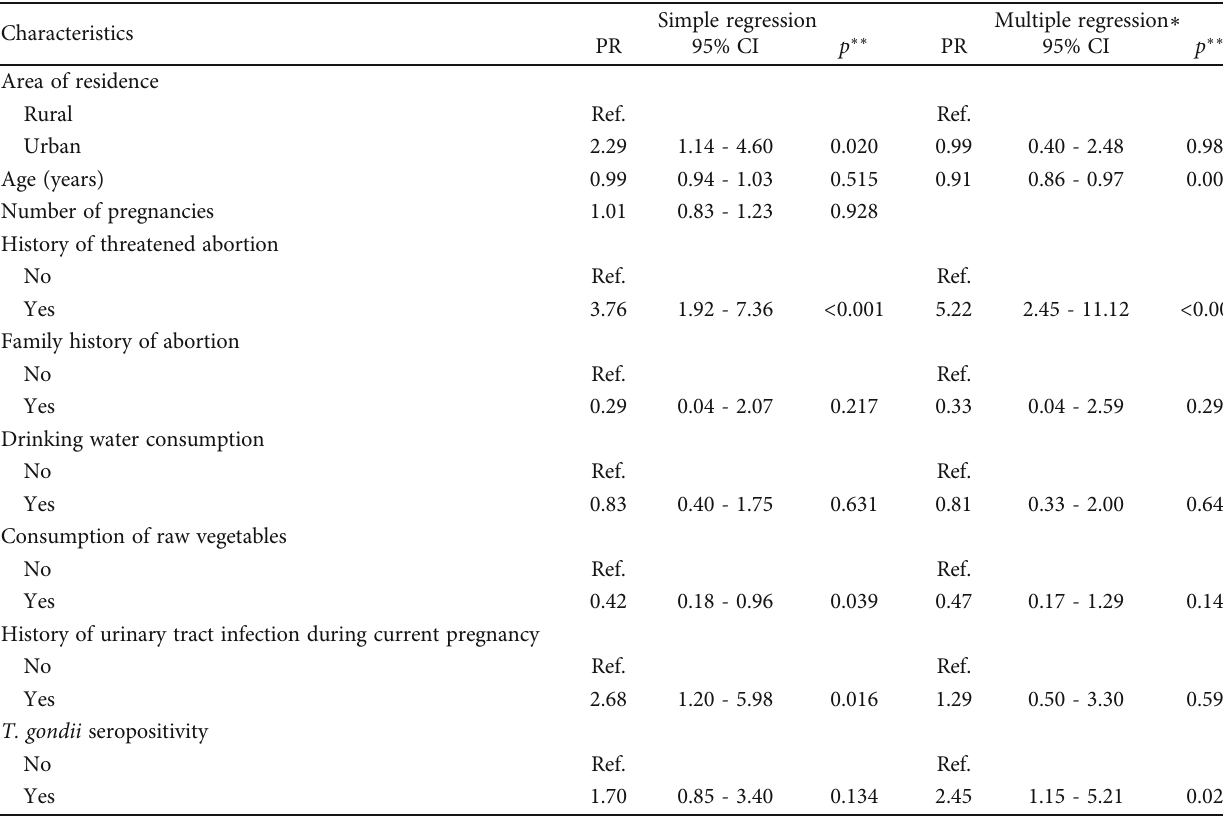
Table 3: Association between T. gondii seropositivity and threatened abortion in pregnant women, simple and multiple regression analysis.